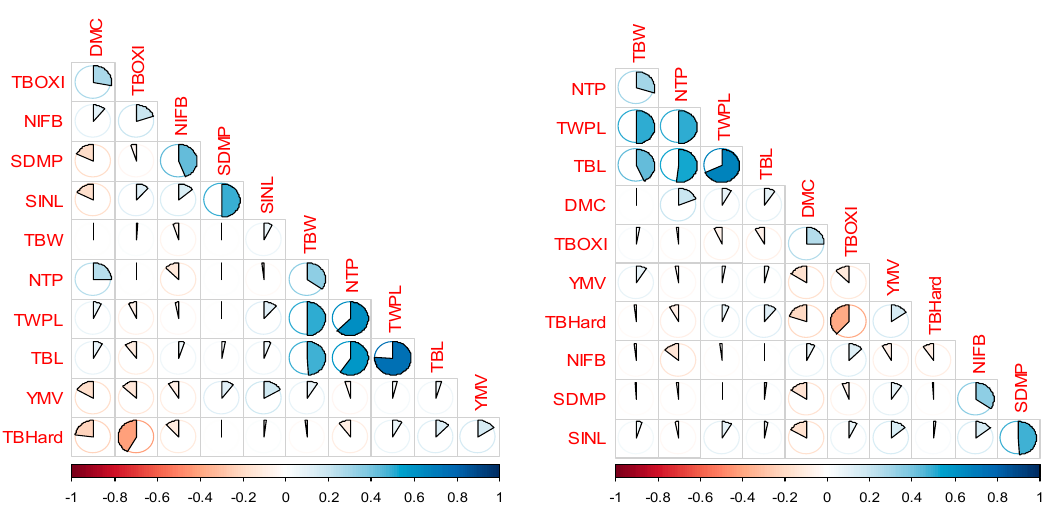
The results of the phenotypic and genotypic relationships among the quantitative